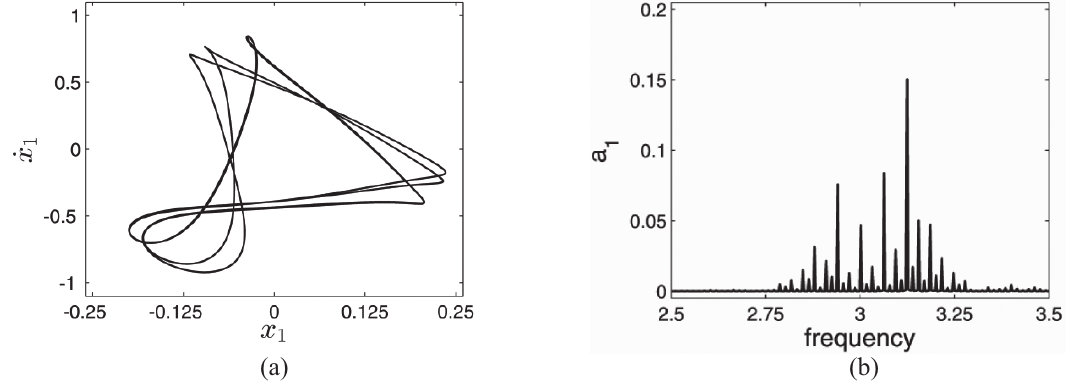
Fig. 14. Poincaré map (a) and fast Fourier transform (b) of the beam response; x 0 = 0.01, Ω = 3.06309, α 2 = 0.00306, α 1 = 0.01.